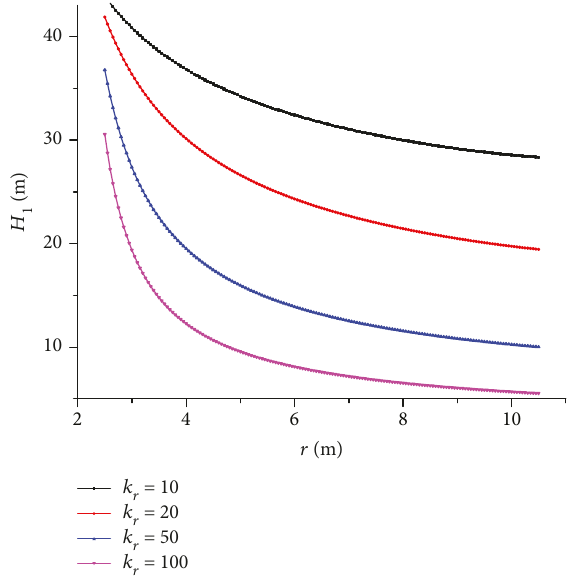
Figure 11: Relationship between the karst water in fl ow and permeability coe ffi cient of the grouting circle.